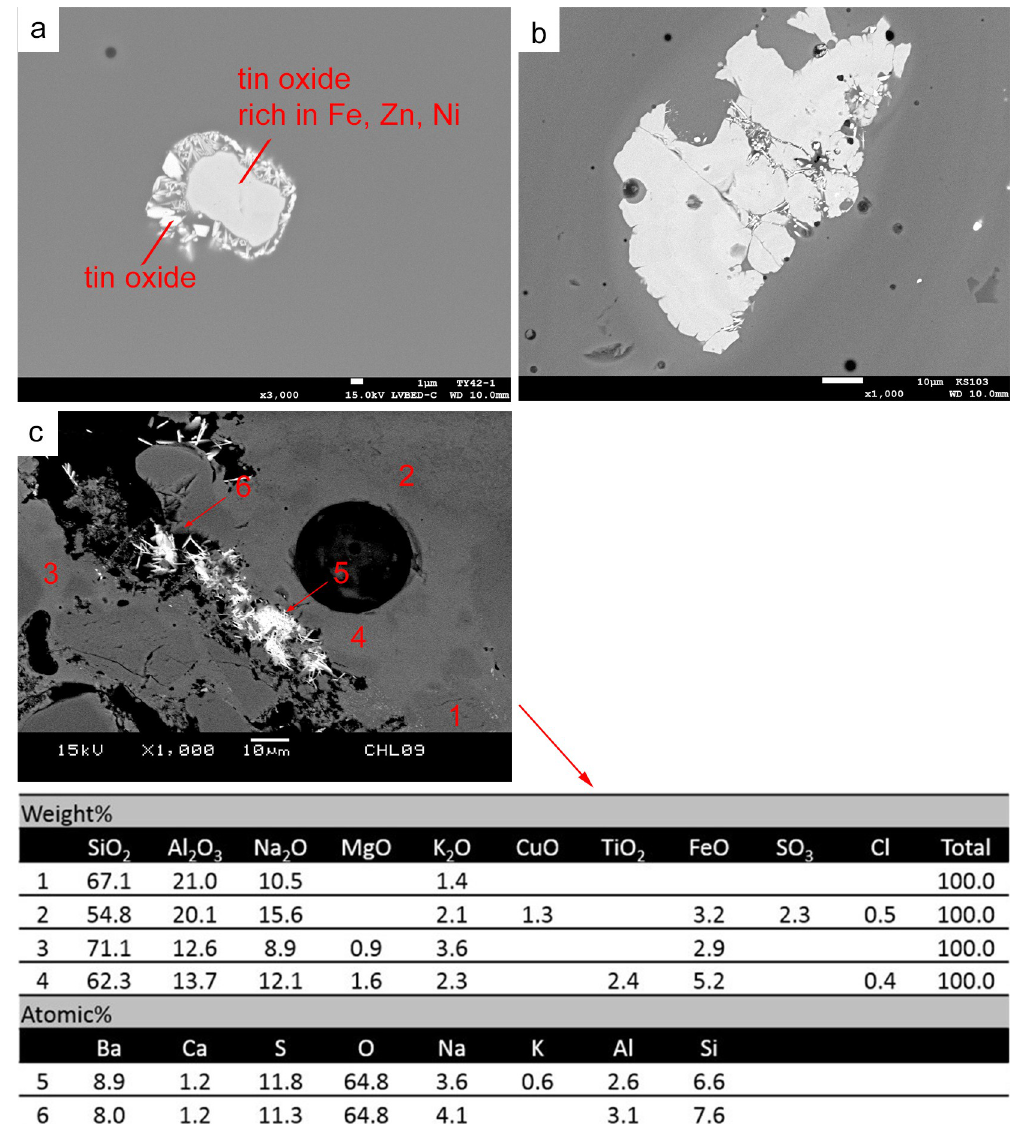
Fig 8. BSE image showing microstructure of green glass, in which (a) a tin oxide rich in Fe, Zn and Ni is found (DY42-1), (b) a tin-rich inclusion containing Ca, Al and Si is observed (GS103), and (c) a visible red inclusion showing inhomogeneous distribution of CuO, TiO 2 , FeO and SO 3 , as well as prismatic barite crystals and partially melted sodium aluminosilicate